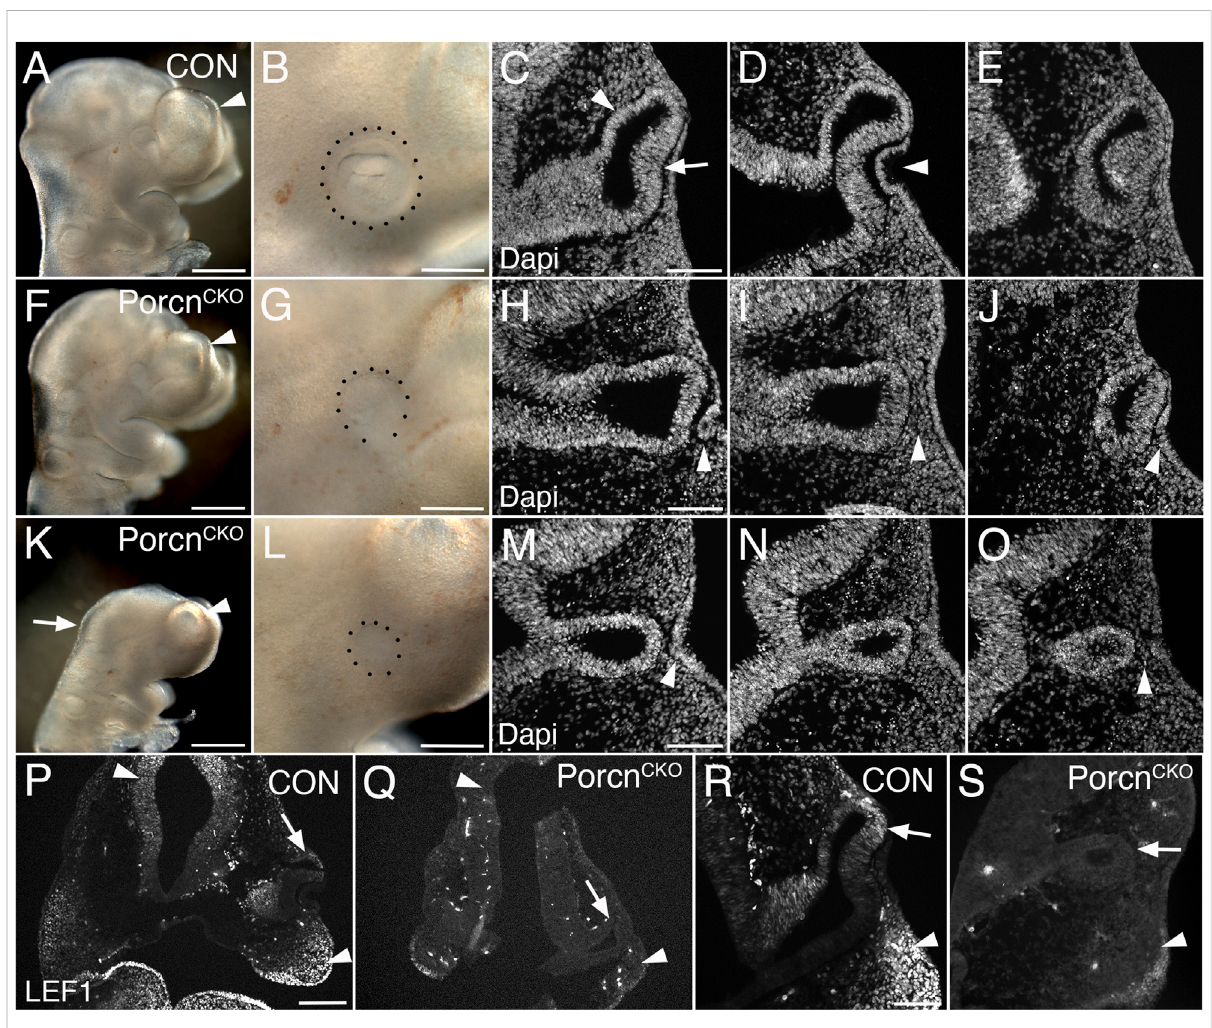
Conditional Porcn inactivation during eye fi eld formation (E7.4-7.5) causes a range of brain and ocular abnormalities at E10.5. (A – E) Control Porcn CHET embryosshowingtelencephalicvesicle(A;arrowhead),earlyOCwithlensvesicle(B;dottedoutline),presumptiveRPEandneuralretina(C; arrowhead and arrow, respectively) and invaginating lens vesicle (D; arrowhead) in sequential Dapi-labeled coronal sections (C – E) . (F – J) Porcn CKO with mild abnormalities; reduced telencephalic vesicle size (F; arrowhead), reduced eye size (G) , incomplete invagination of OV and lens ectoderm (H, J; arrowheads) and accumulation of POM between distal OV and lens ectoderm (I; arrowhead). (K – O) Porcn CKO with major defects showing loss of the mid-hindbrain border and further reduction of telencephalic vesicles (K; arrow and arrowhead, respectively), microphthalmia (L; dotted outline, compare B, G, L), arrested OV (M – O) and accumulation of POM (O; arrowhead). Some thickening of the surface can occur (M; arrowhead). (P – S) LEF1 immunolabeling of coronal control Porcn CHET sections shows expression in the dorsal forebrain (P, left arrowhead), facial primordia mesenchyme (P; right arrowhead, R; arrowhead) and dorsal OC (P, R; arrows). In Porcn CKO embryos, LEF1 is severely reduced in the dorsal forebrain (Q; left arrowhead), facial primordia (Q; right arrowhead, S; arrowhead) and dorsal OC (Q, S; arrows). Scale bars A, F, K: 0.5 mm; B, G, L, P: 0.2 mm; C, H, M, R: 0.1